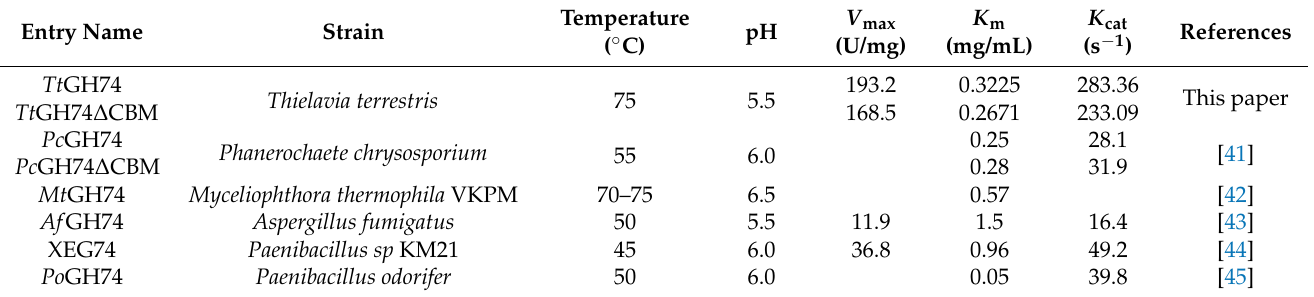
Table 2. Comparison of the biochemical properties of Tt GH74 and Tt GH74 ∆ CBM with other GH74